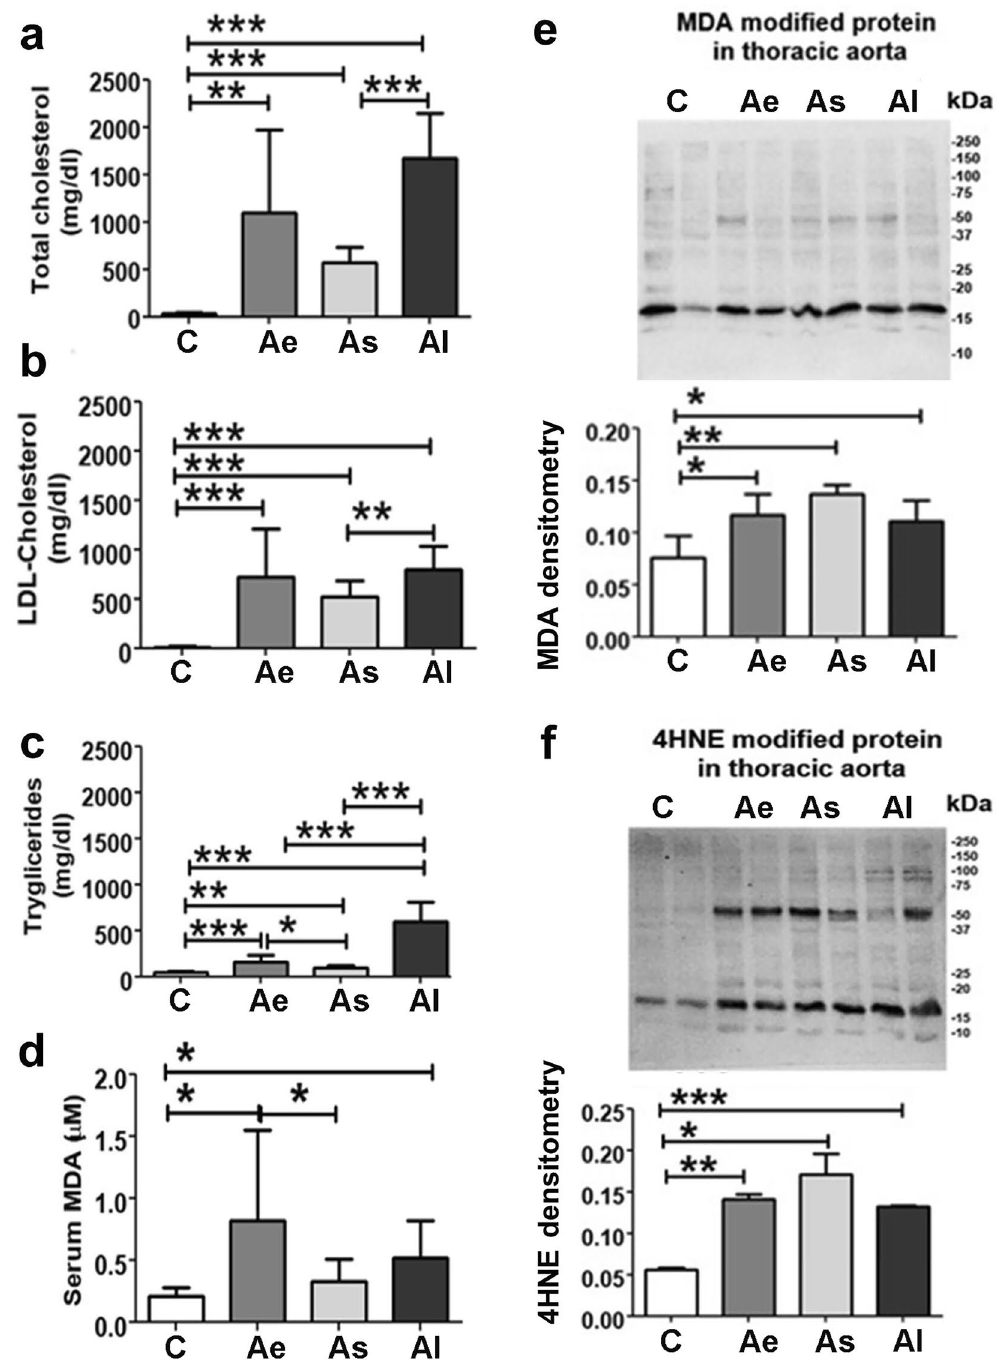
Figure 2. Biochemical lipid assays in sera and Western blot for malondialdehyde- (MDA) and 4-hydroxynonenal- (4HNE) protein level in the ascending aorta’s homogenate. Sera quantitation of ( a ) total cholesterol, ( b ) LDL-cholesterol, ( c ) triglycerides and ( d ) MDA levels for all animal groups included in the study after twelve weeks. Tissue homogenate Western blotting and associated densitometric analysis showed changes in ( e ) MDA- and ( f ) HNE-protein level in the four experimental groups. Ponceau S staining was used for normalisation of the proteins’ levels. C: control group (n = 7), Ae: early atherosclerotic group (n = 6), As: stabilized atherosclerotic group by lipid-lowering treatment (n = 8) and Al: late atherosclerotic group (n = 8). Data are expressed as means ± standard deviation (SD); * p ˂ 0.05; ** p ˂ 0.01; *** p ˂ 0.001. Full images of Western Blot membranes included in this figure can be found in Supplementary